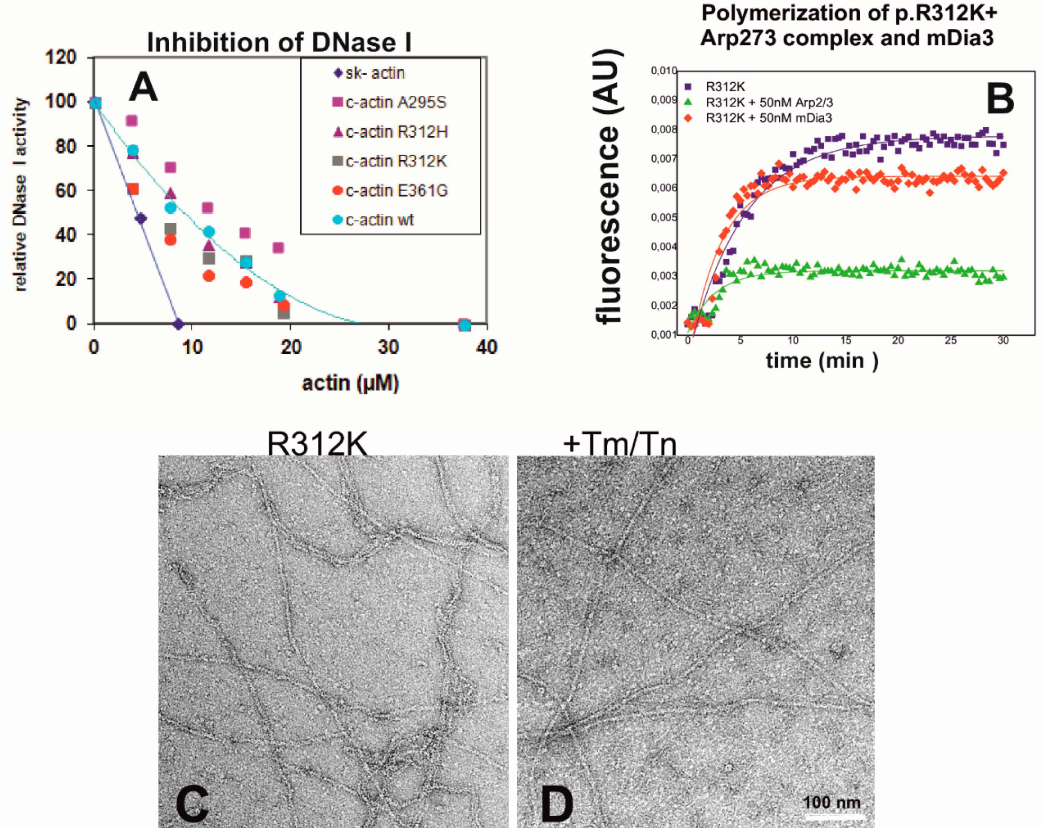
Figure 3. Properties of the purified p.R312K c-actin variant. ( A ) Inhibition of DNase I by the c-actin variants. The inhibition by p.R312K is shown by the trendline. ( B ) Rates of polymerization of the c-actin variants. The rate of 5 µ M p.R312K is shown by ( (cid:7) ) and coincides with the rate of wt c-actin. ( C ) Influence of 50 nM Arp2/3 complex and 50 nM mDia3-FH2 of the rate of polymerization of p.R312K. ( C ) EM images of polymerized p.R312K without and ( D ) after decoration with cTm and cTn at 7:1:1 ratio to actin. Bar in ( D ) corresponds to 100